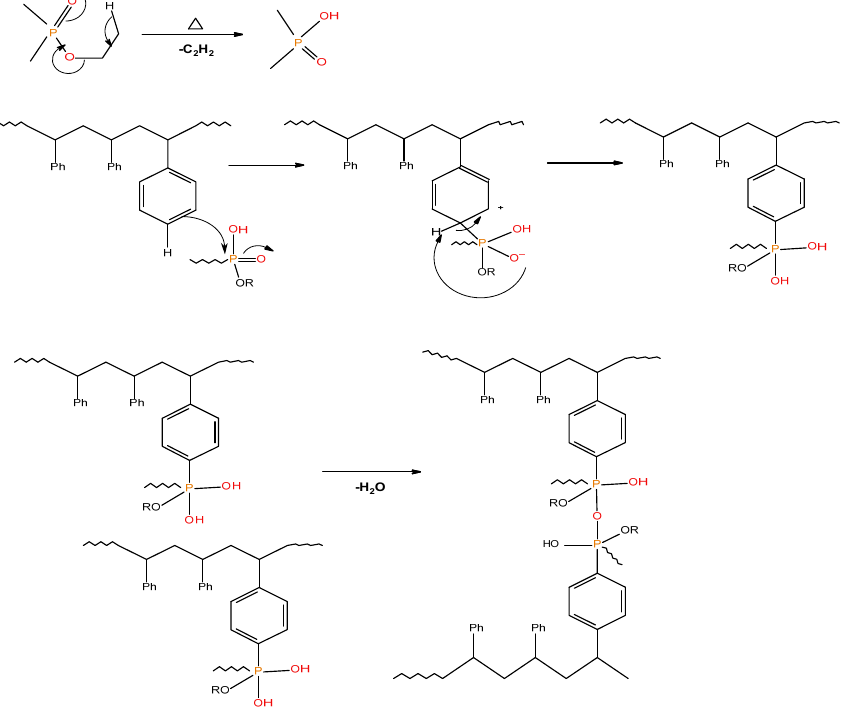
Figure 6. A schematic representation of the possible pathway leading to cross-linking and formation of polyphosphate linkages in modified PSt-based materials.